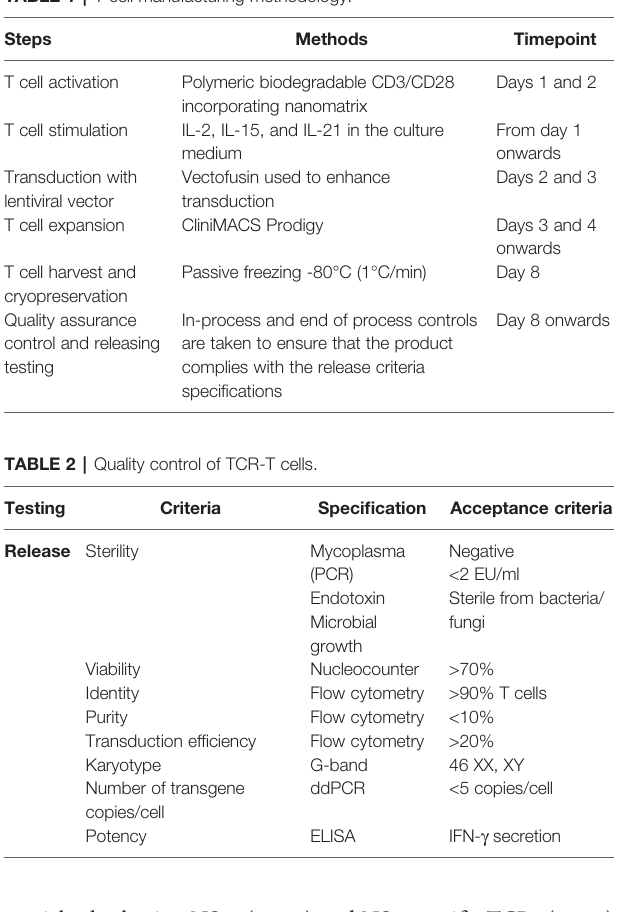
TABLE 1 | T cell manufacturing methodology.